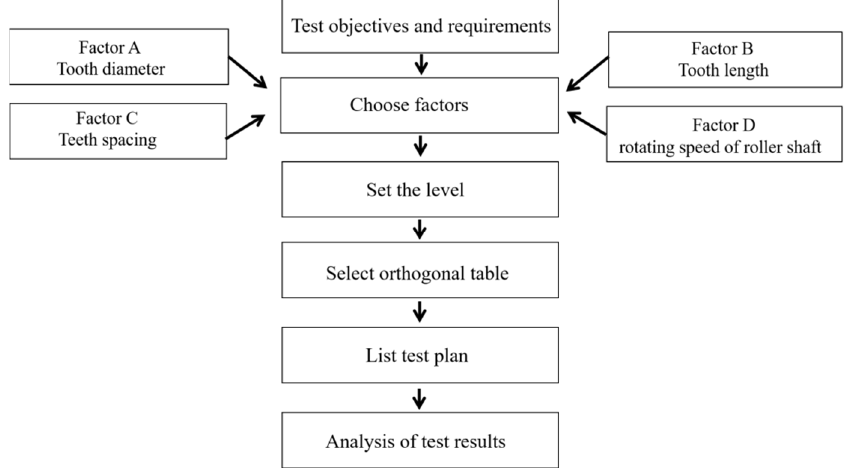
Figure 6. The experimental process using the OED method. Table 2. Levels and factors affecting LFM cleaning quality.